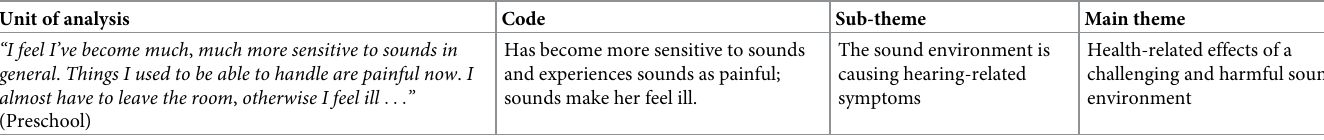
Table 2. An example of the process of abstraction. Unit of